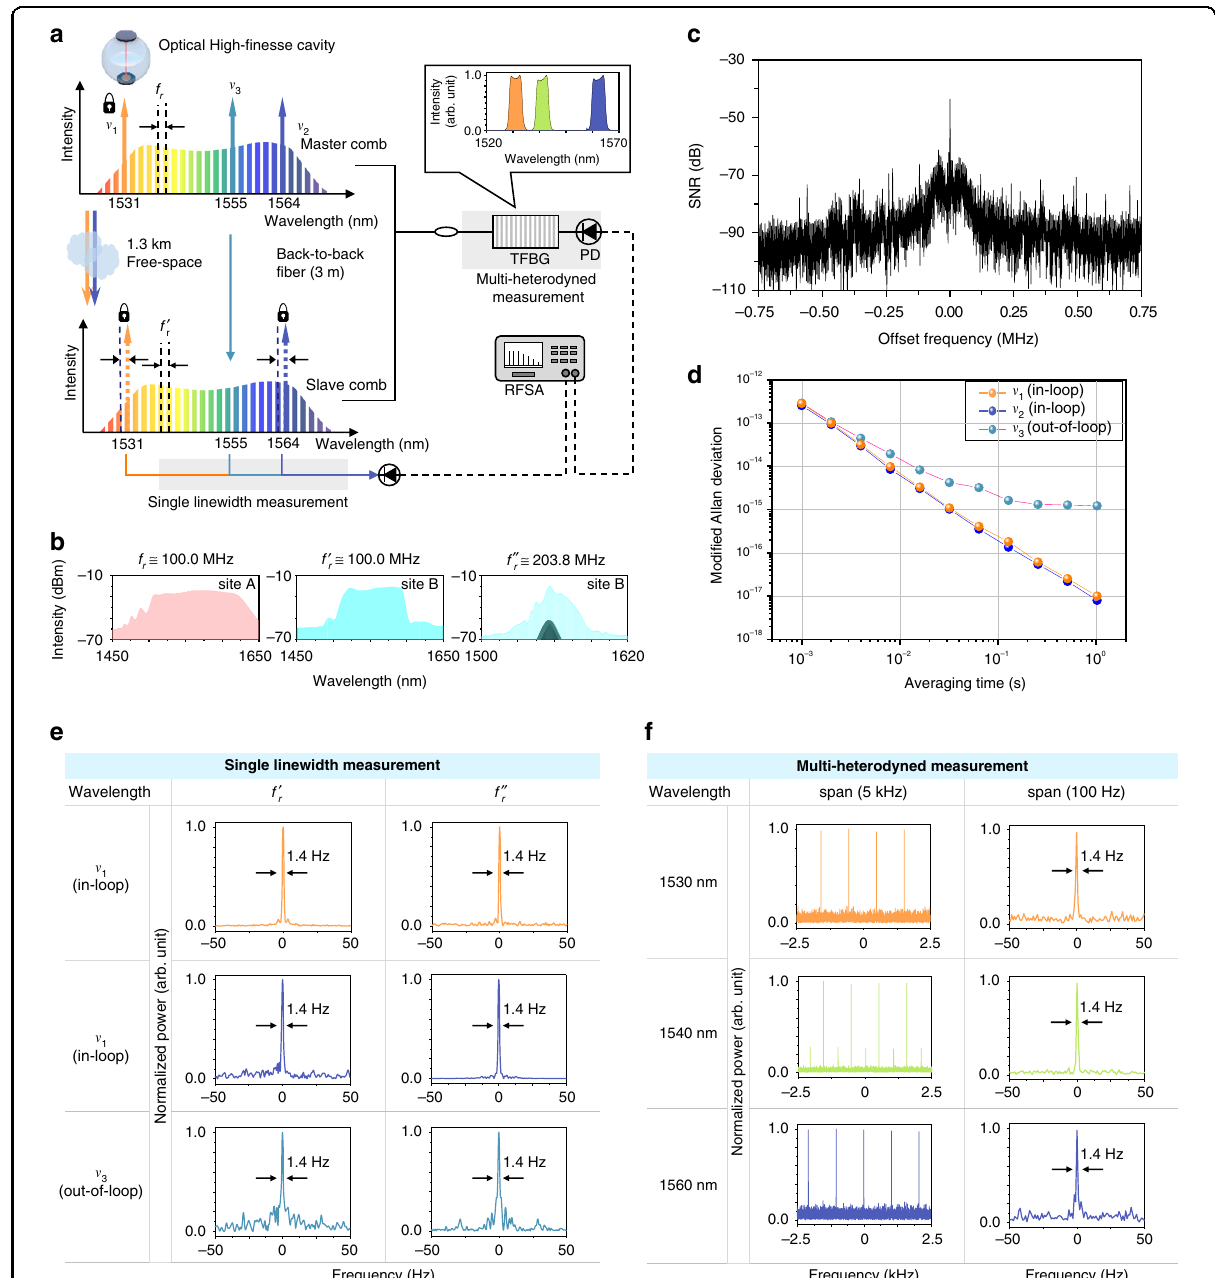
Fig. 2 Mode-to-mode veri fi cation of comb-to-comb stabilization. a The slave comb is connected to the master comb through a short fi ber line for back-to-back evaluation. Mode-to-mode relative stability is monitored for two in-loop frequencies ( ν 1 , ν 2 ) and one out-of-loop frequency ( ν 3 ). b Optical spectra of the master comb ( f r = 100.0 MHz) and two distinct slave combs ( f r ′ = 100.0 MHz and f r ″ = 203.8 MHz). The original spectrum of f r ″ is given in dark green while its broadened spectrum in light blue. c RF spectrum of the mode-to-mode error signal for the in-loop frequency ν 1 . d Allan deviations of the in-loop and out-of-loop frequencies. e Modal linewidth measurement. f Multi-heterodyne modal linewidth measurements at three different fi lter frequencies (orange:1530 nm, green: 1540 nm, blue: 1560 nm). TFBG Tunable fi ber Bragg grating, PD Photo-detector, and RFSA Radio frequency spectrum